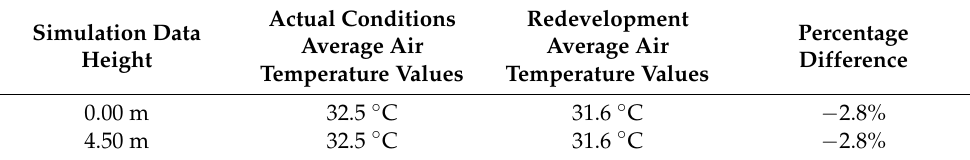
and redeveloped conditions.